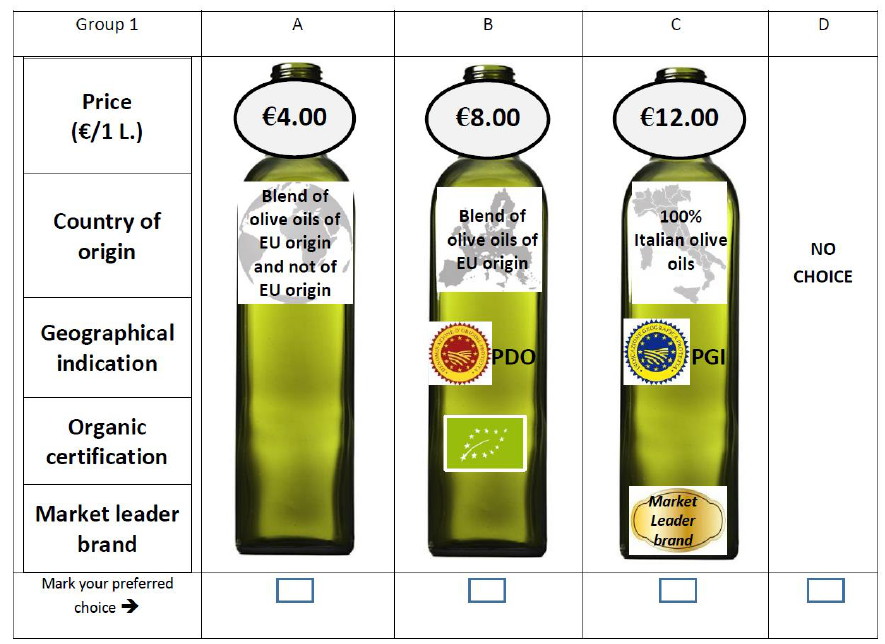
Figure 1. A choice set example for one of the six sets proposed.